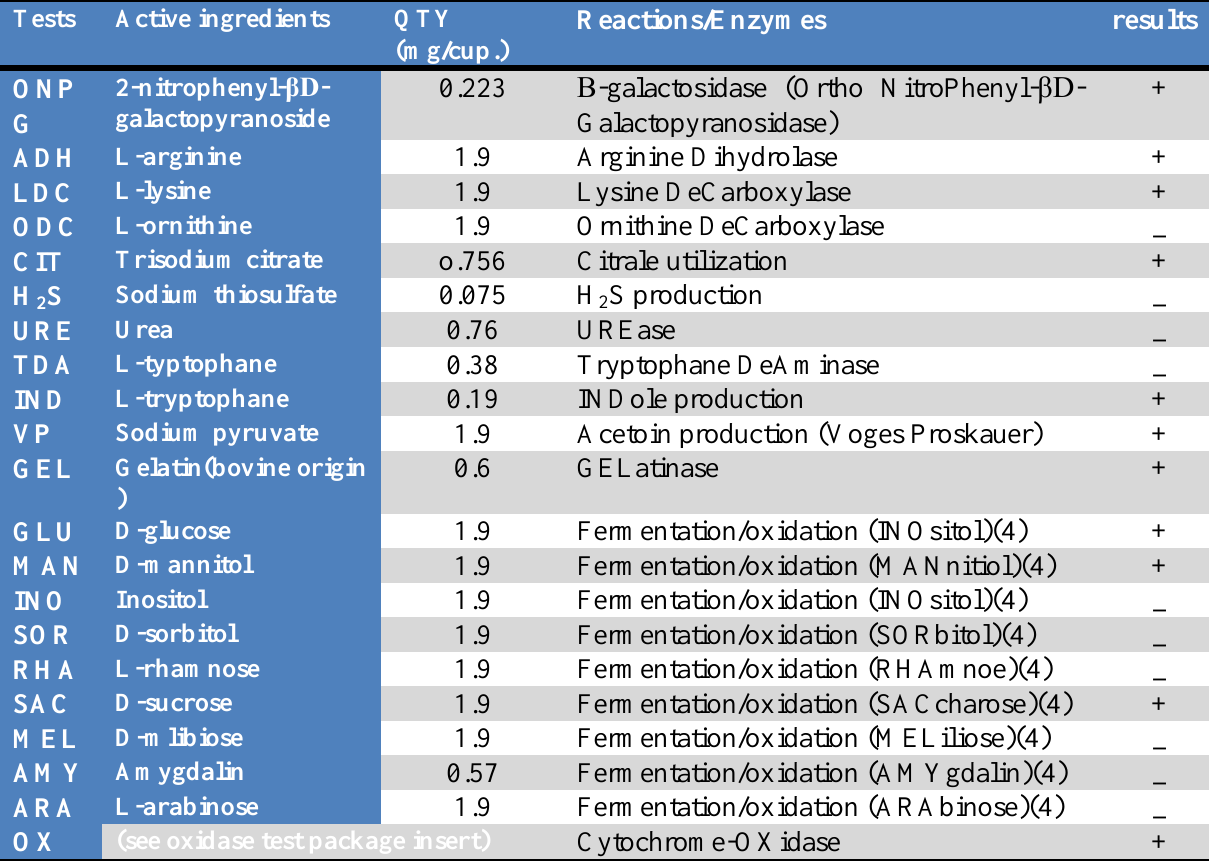
Table (1) Identification of bacterial isolates by the API 20E rapid identification